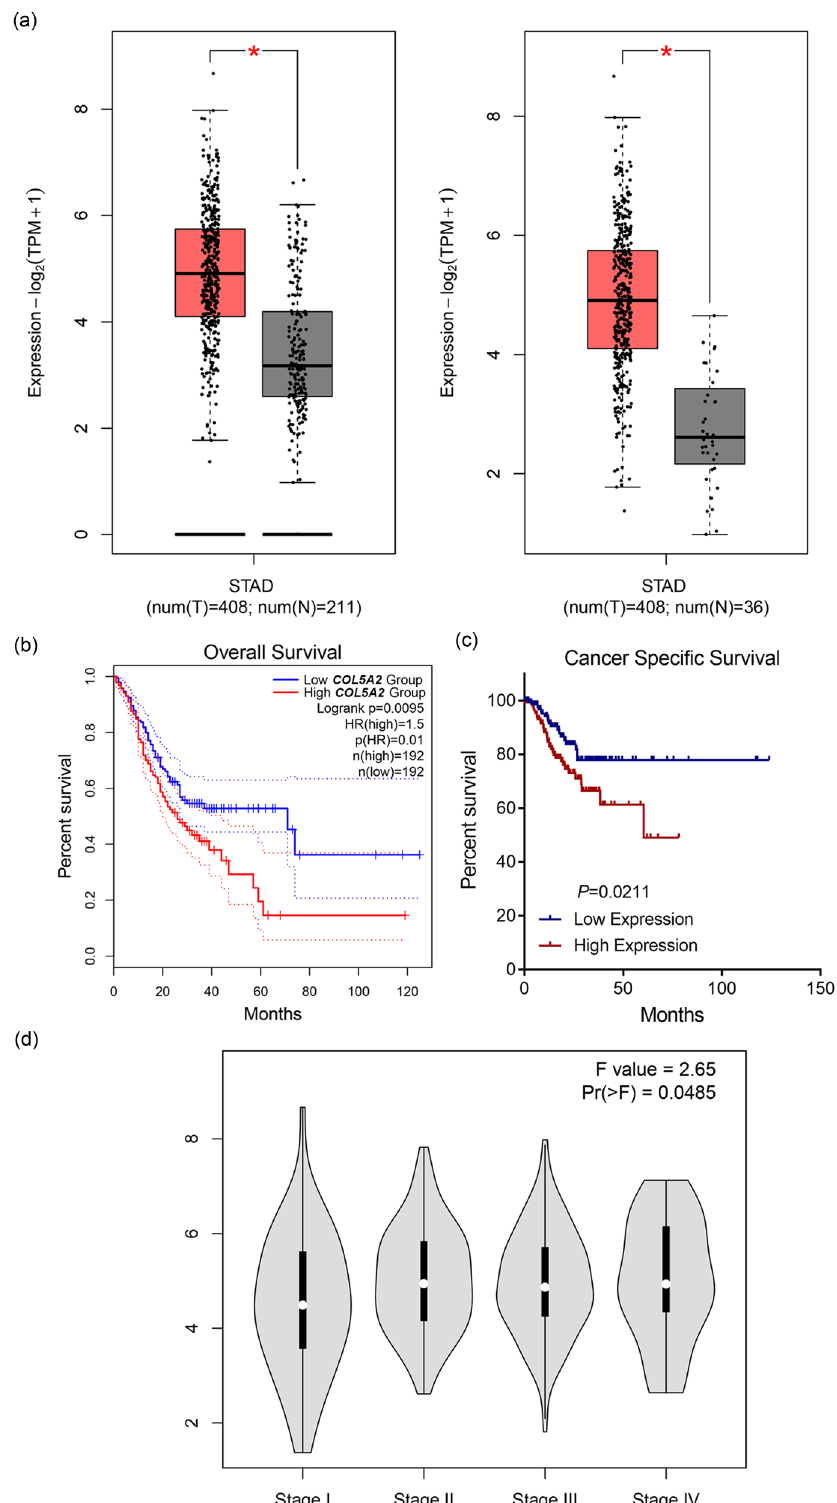
Figure 2: GEPIA analysis revealed that the mRNA expression of COL5A2 was up - regulated in GC. ( a ) mRNA expression of COL5A2 was analyzed in GEPIA combined with TCGA ( left ) or GTEx database ( right ) ; * P < 0.05. ( b ) KM survival curves of the overall survival for COL5A2 were plotted, and patients in COL5A2 high expression group had a shorter survival than those in COL5A2 low expression group. ( c ) KM survival curves of the GC - speci fi c survival for COL5A2 was plotted, and patients in COL5A2 high expression group had a shorter survival than those in COL5A2 low expression group. ( d ) Association between COL5A2 expression and tumor stages of GC was analyzed by stage